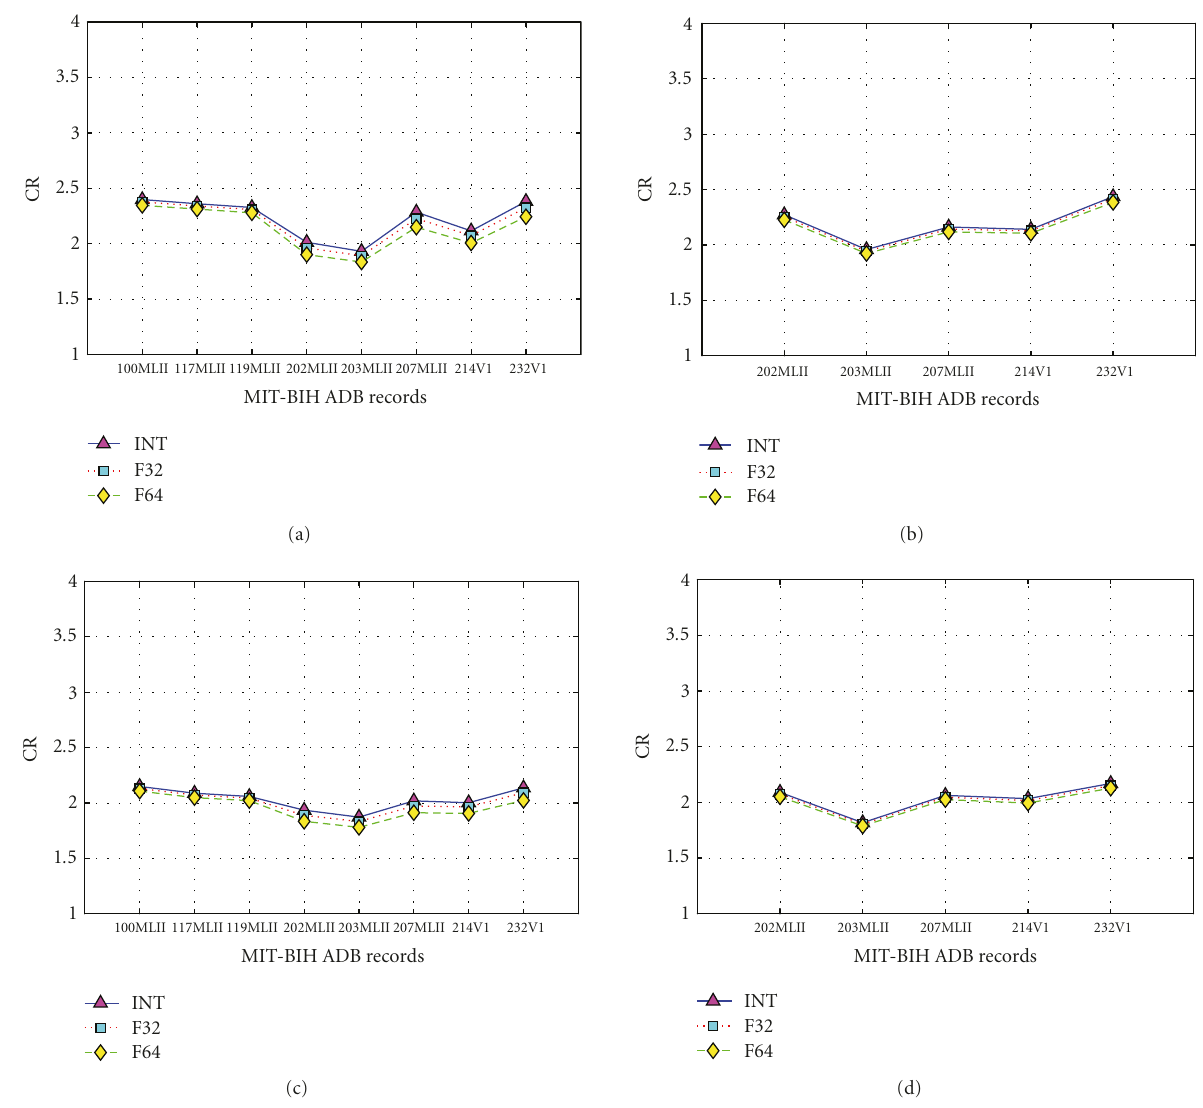
Figure 11: Results with floating-point and fixed-point representations for the trained weights and biases with PA scheme using (a) ABT and (b) SBT; and with PRA scheme using (c) ABT and (d)